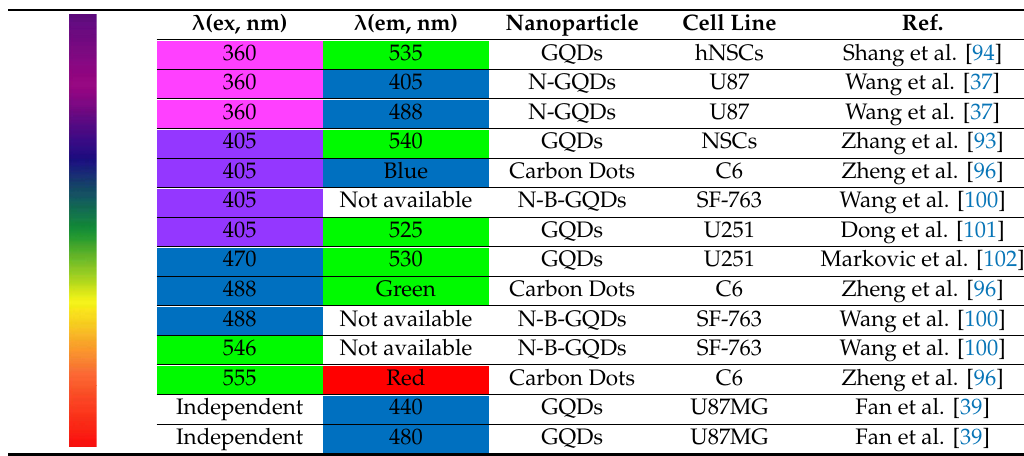
Table 3. Wavelengths reported in this review for bioimaging, phototherapy and drug delivery on neural cell lineages.